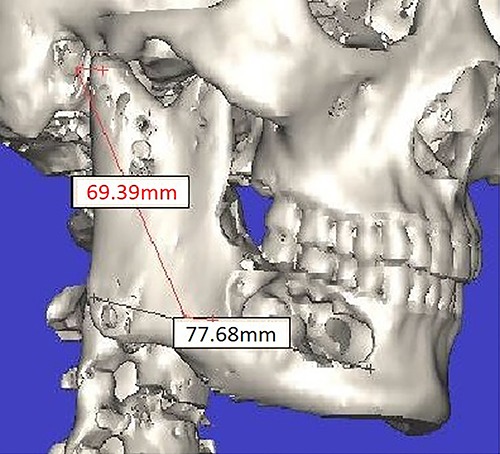
Reverse measurement.